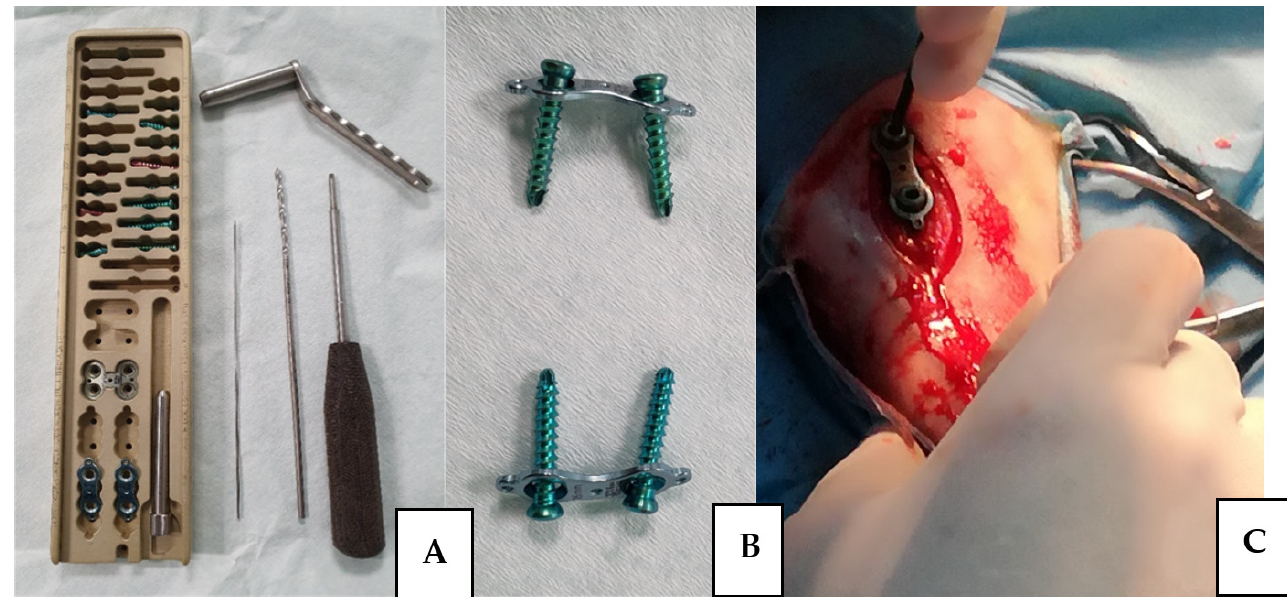
Figure 1. ( A ) Photography of the standard eight plate systems equipped with elastic plate. ( B ) Two screws and the implant which were used in the experiment. ( C ) The implantation of the eight plate system in the ovine tibia.